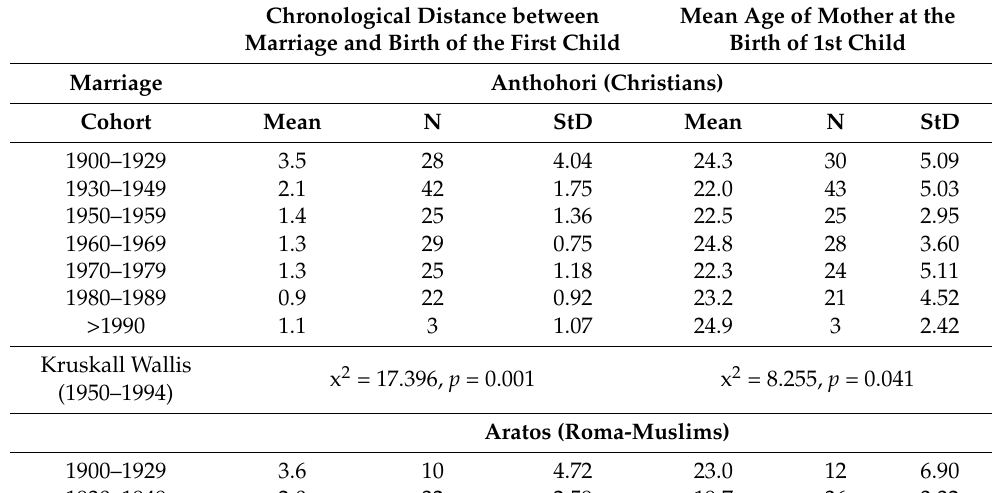
Table 2. Chronological gap between marriage and birth of first child. Mean age of mother at the birth of first child. First marriage of the